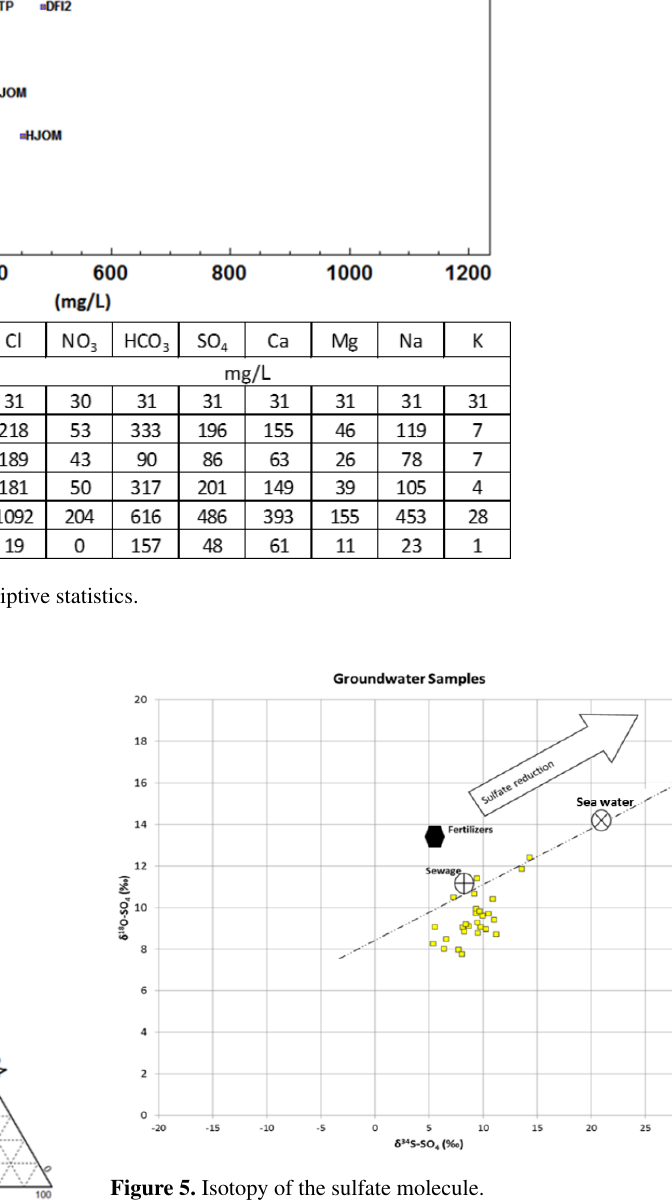
Figure 5. Isotopy of the sulfate